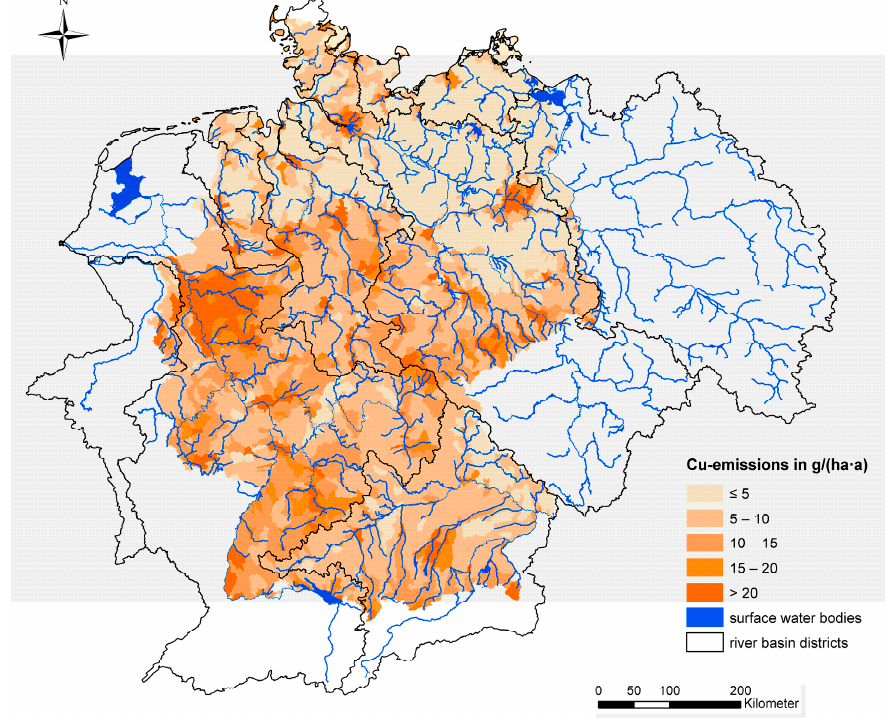
Figure 6. Mean area-specific copper emissions from the analytical units into the surface water bodies in Germany for the years 2012–2014.